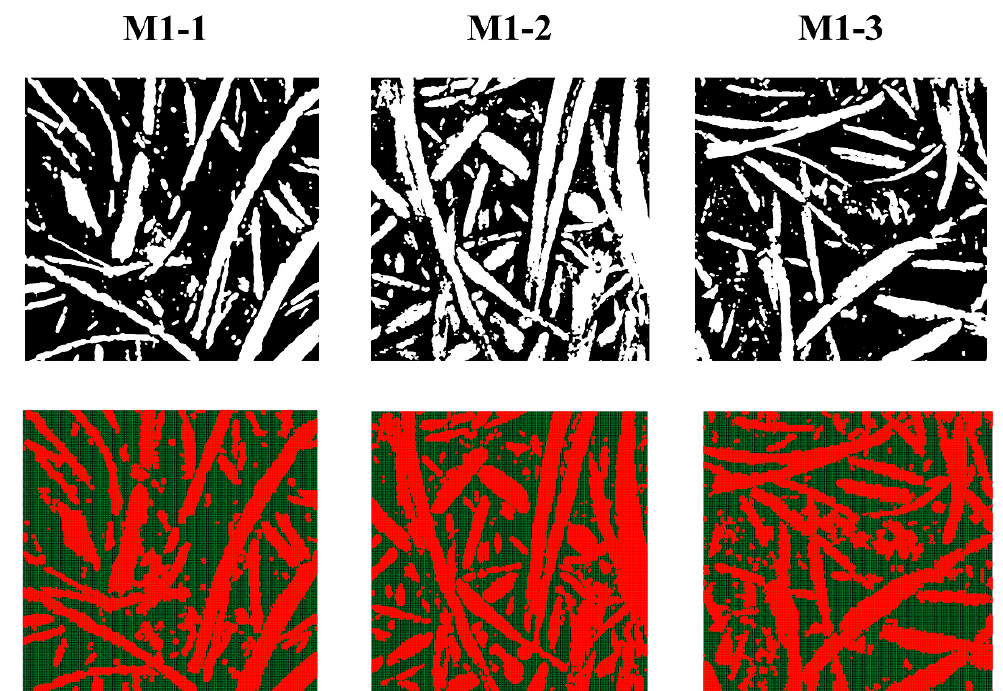
Figure 4. Method 1 modified images and their respective generated finite element analysis (FEA) meshes. M1-1 stands for Method 1-Sample 1.